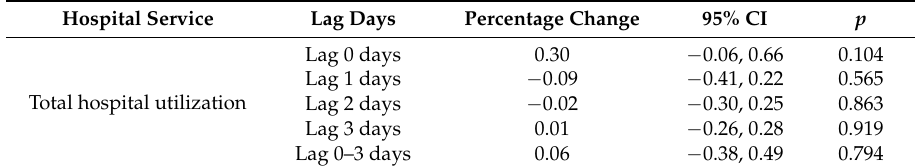
Table 3. The effect of a 10 µ g/m 3 increase in fine particulate matter (PM 2.5 ) concentration on URTI-related hospital utilizations for different lag